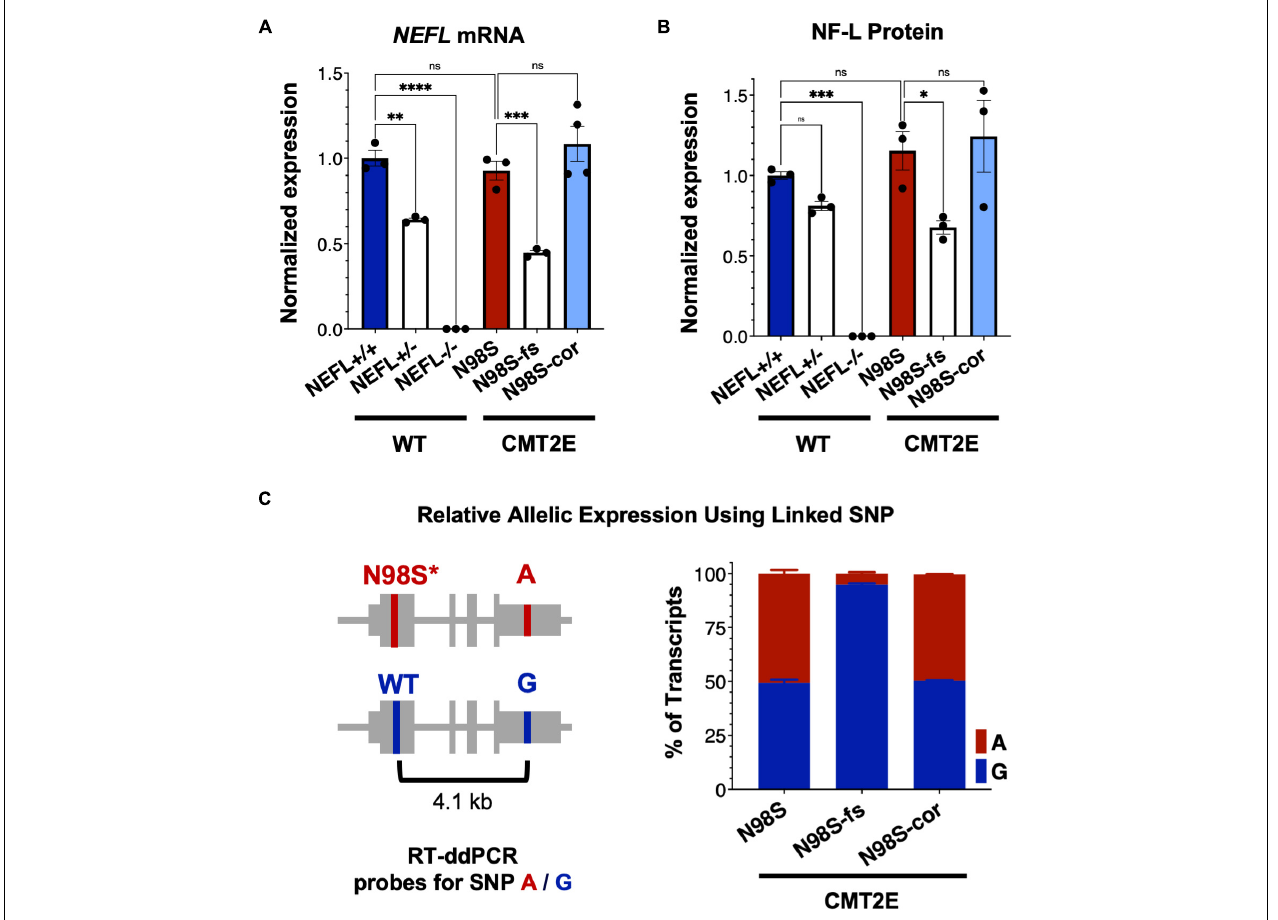
FIGURE 4 | NEFL expression in allelic series of edited motor neurons. A series of edited iPSCs derived from a healthy control (WT) and CMT2E patient were differentiated into i 3 LMNs, and RNA was extracted on day 7 or protein on day 10. (A) Total NEFL transcript expression by quantitative RT-ddPCR, normalized to GAPDH . (B) Total NF-L protein expression by western blot, normalized to GAPDH. (C) Relative expression of NEFL alleles in i 3 LMNs derived from CMT2E patient line and edited subclones. Allele-specific RT-ddPCR targeting a heterozygous SNP in the 3 (cid:48) UTR was used to genotype transcripts using linkage shown in the schematic. All bar graphs represent mean ± S.E.M. For all graphs ns = not significant, * p < 0.05, ** p < 0.01, *** p < 0.001, **** p < 0.0001 by one-way ANOVA with Šídák’s test for multiple